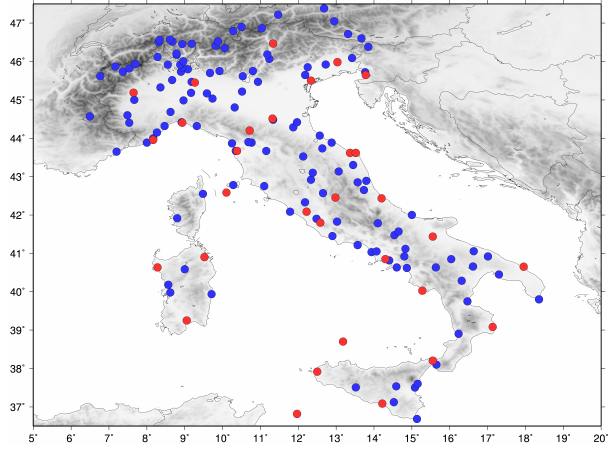
Figure 1. Stations with sunshine duration records. Red dots: also global radiation